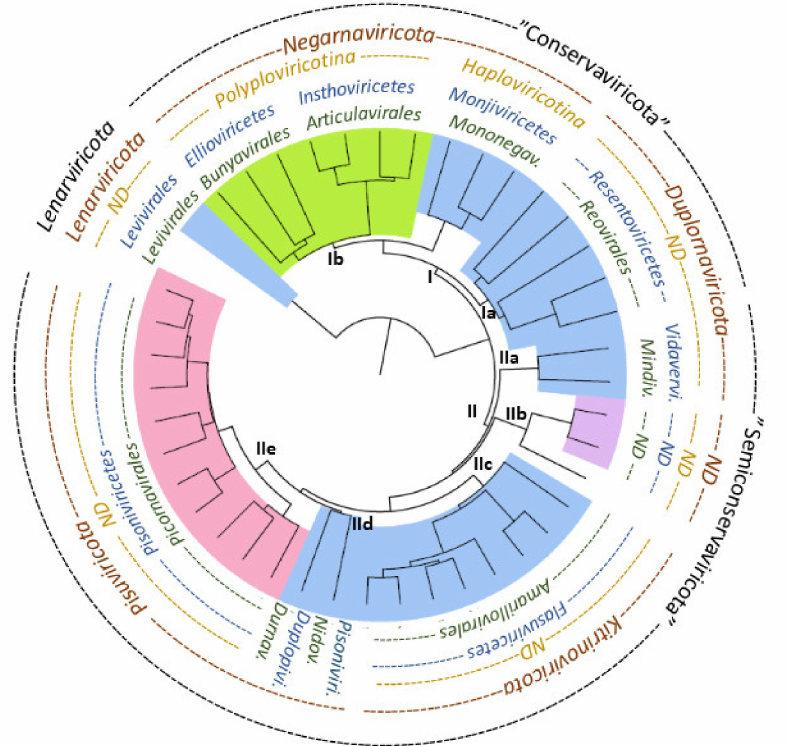
Figure 3. The higher order taxonomy of RNA viruses at order, class, subphylum and phylum ranks depicted on the structure-based distance tree. The different ranks are on green, blue, dark yellow and maroon fonts, respectively. The phylum level classification proposed here is on black font. For branch background colors, please see Figure 2. Abbreviations v . and vi . refer to virales and viricetes ,